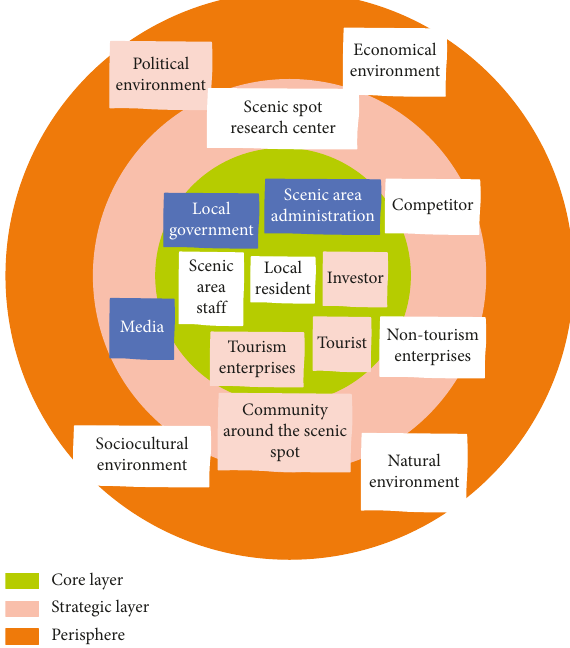
Figure 2: Stakeholder hierarchy diagram of tourist scenic